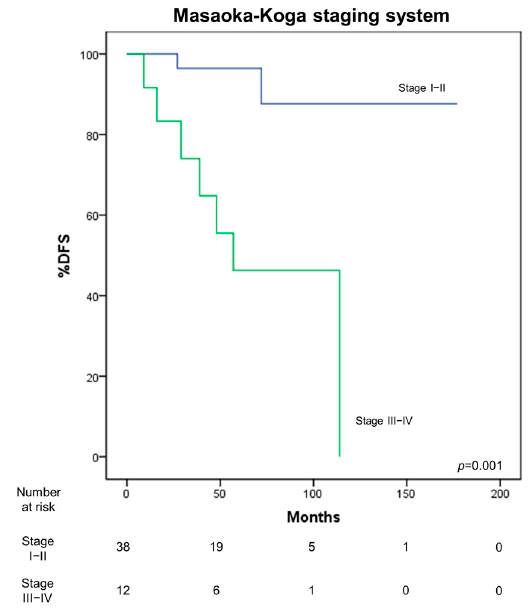
Figure 4. Correlation between disease-free survival (DFS) and Masaoka–Koga staging system.